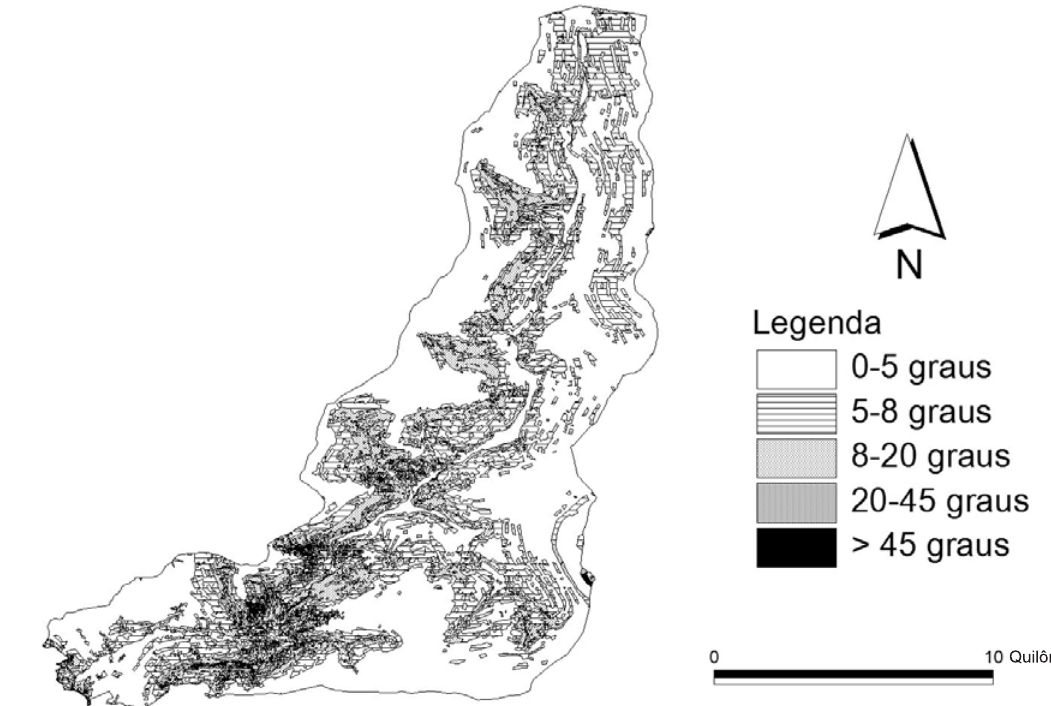
Figura 3. Declividade das vertentes da bacia do ribeirão Pipiripau. Fonte: CAESB